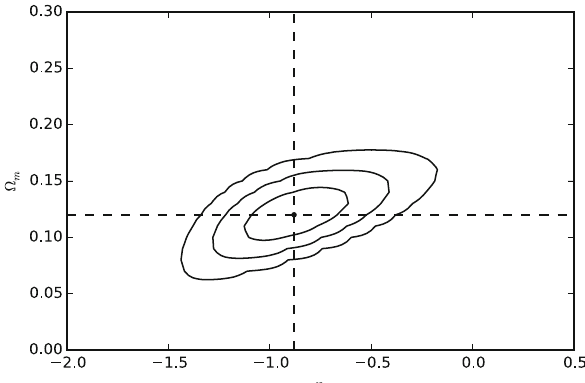
Fig. 5 The 1 σ , 2 σ and 3 σ confidence regions of the effective parame- = 69 . 32 ± 0 . 80km s − 1 Mpc − 1 , ters n , Ω D 0 m withGaussianpriorof H D 0 where the best-fits are n = − 0 . 88, and Ω D 0 m = 0 . 12